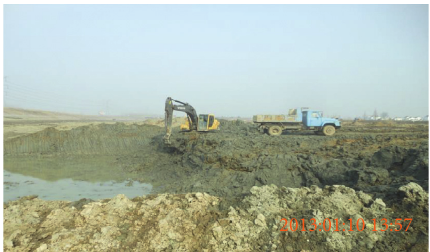
Figure 2: Soft clay being excavated adjacent to the Qingyi River for sampling.